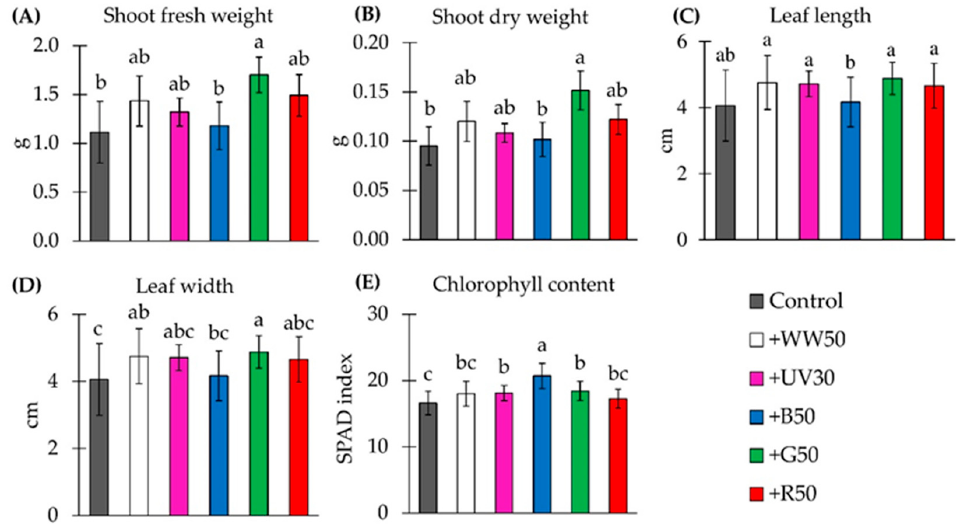
Figure 1. Growth and morphological parameters and chlorophyll content of ‘Rouxai’ baby-leaf lettuce on harvest day. Plants were grown under six lighting treatments at a photon flux density of 200 µ mol m − 2 s − 1 from warm–white (WW; peak = 639 nm) LEDs (control treatment) without or with an additional 30 µ mol m − 2 s − 1 of UV-A (peak = 385 nm) (+UV30) or 50 µ mol m − 2 s − 1 of WW, blue (B; peak = 449 nm), green (G; peak = 526 nm) or red (R; peak = 664 nm) (+WW50, +B50, +G50, and +R50, respectively) light. For shoot fresh weight ( A ), shoot dry weight ( B ), leaf length ( C ), leaf width ( D ), and chlorophyll content ( E ), data are means ± standard deviation (SD) of two replications with 10 samples per replication ( n = 20). The third leaf was measured for leaf length and width ( C , D ). Means with different letters are significantly different from control treatment at the α = 0.05 level by Tukey’s honestly significant difference test .